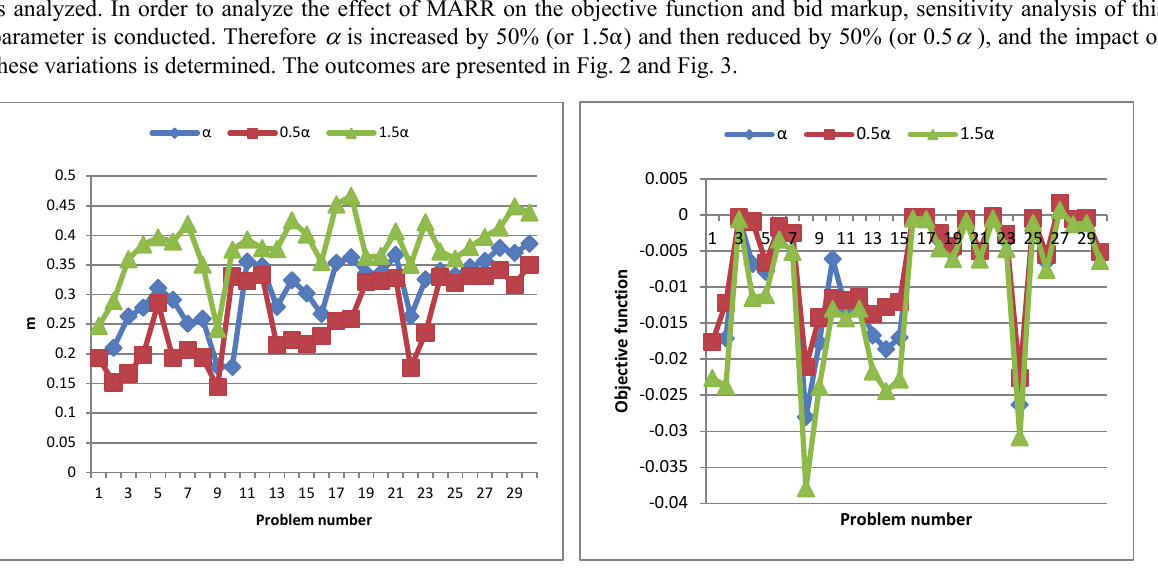
Fig. 2. Effect of MARR on the bid markup Fig. 3. Effect of MARR on the objective